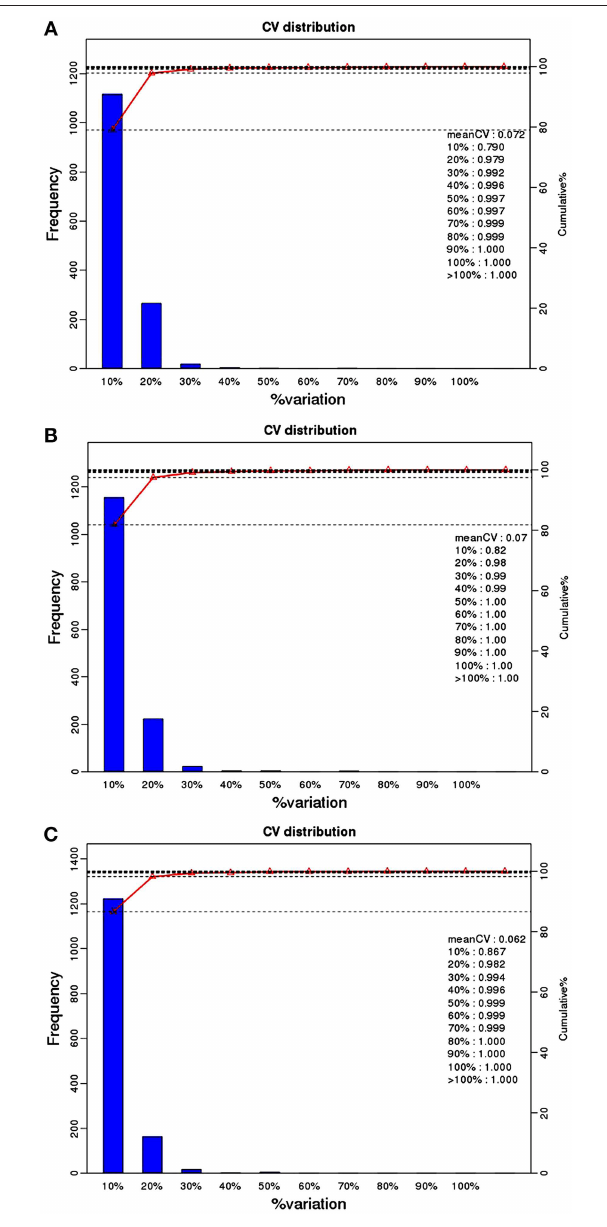
FIGURE 2 | Repeatability assessment of phosphopeptides quantification based on Coefficient of variation (CV) in RH vs. PRU, PRU vs. PYS, PYS vs. RH. The percentage on X-axis represents the values of CV. The left y-axis indicates the number of phosphopeptides and the right y-axis indicates the cumulative percentage of phosphopeptides. (A–C) Represent repeatability assessment of RH vs. PRU, PRU vs. PYS, PYS vs. RH, respectively.